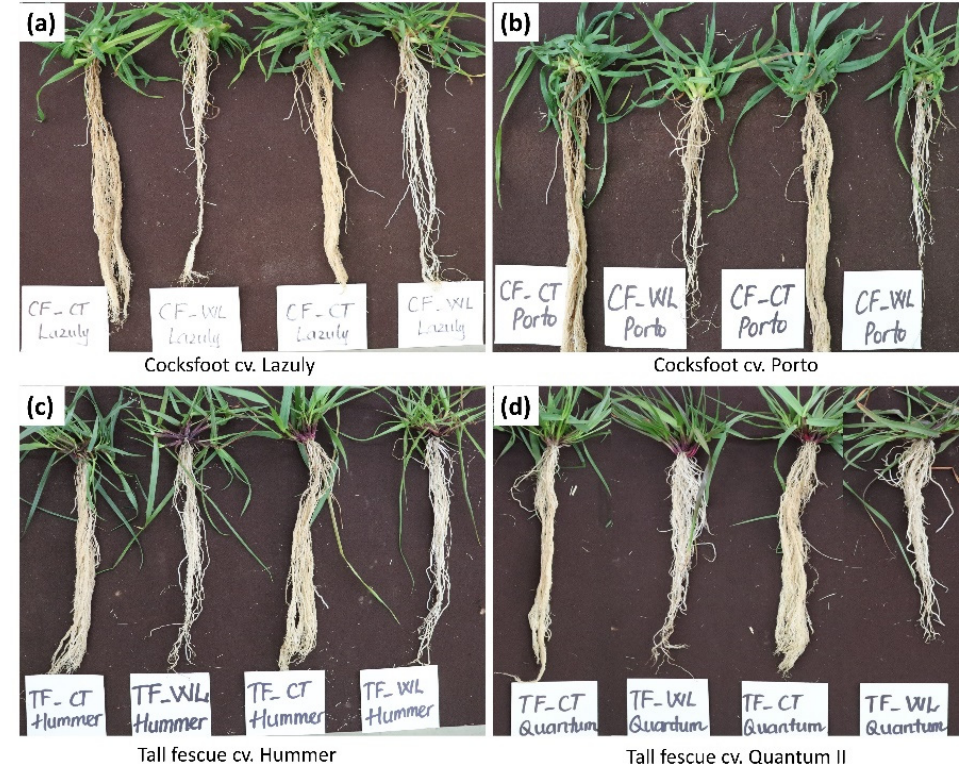
Figure 3. Adventitious roots of 4 cultivars following 28-day waterlogging: a) Lazuly, b) Porto, c) Hummer and d) Quantum II; CF-CT and CF-WL indicate cocksfoot–control and cocksfoot–waterlogging, respectively; TF-CT and TF-WL indicate tall fescue–control and tall fescue–waterlogging, respectively. White-colored roots indicate adventitious roots, whereas darker roots are primary roots.